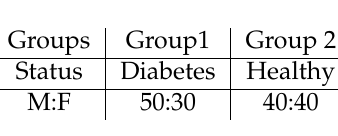
Table 1. Patients distribution